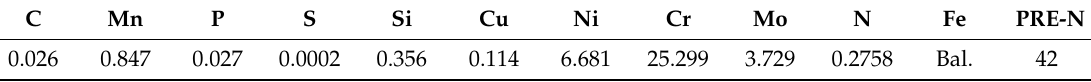
Table 1. Composition of 2507 super duplex stainless steel (SDSS)